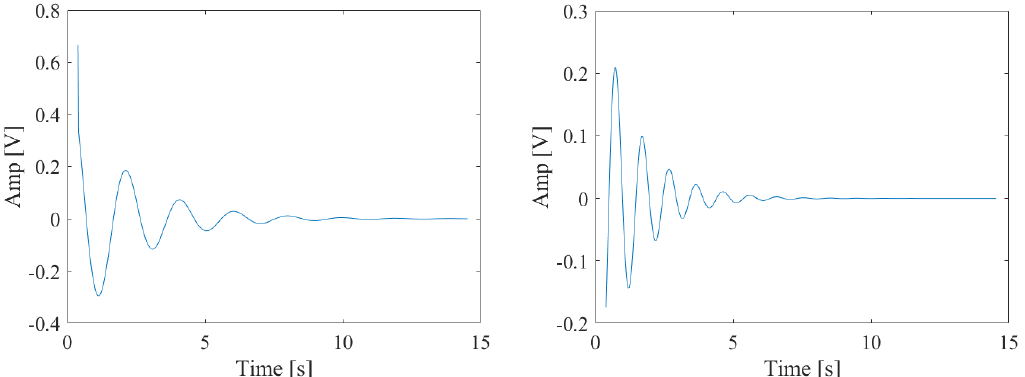
Figure 18. Individual oscillation estimated according to the proposed approach; low frequency signal ( on the left ) and high frequency signal ( on the right ).